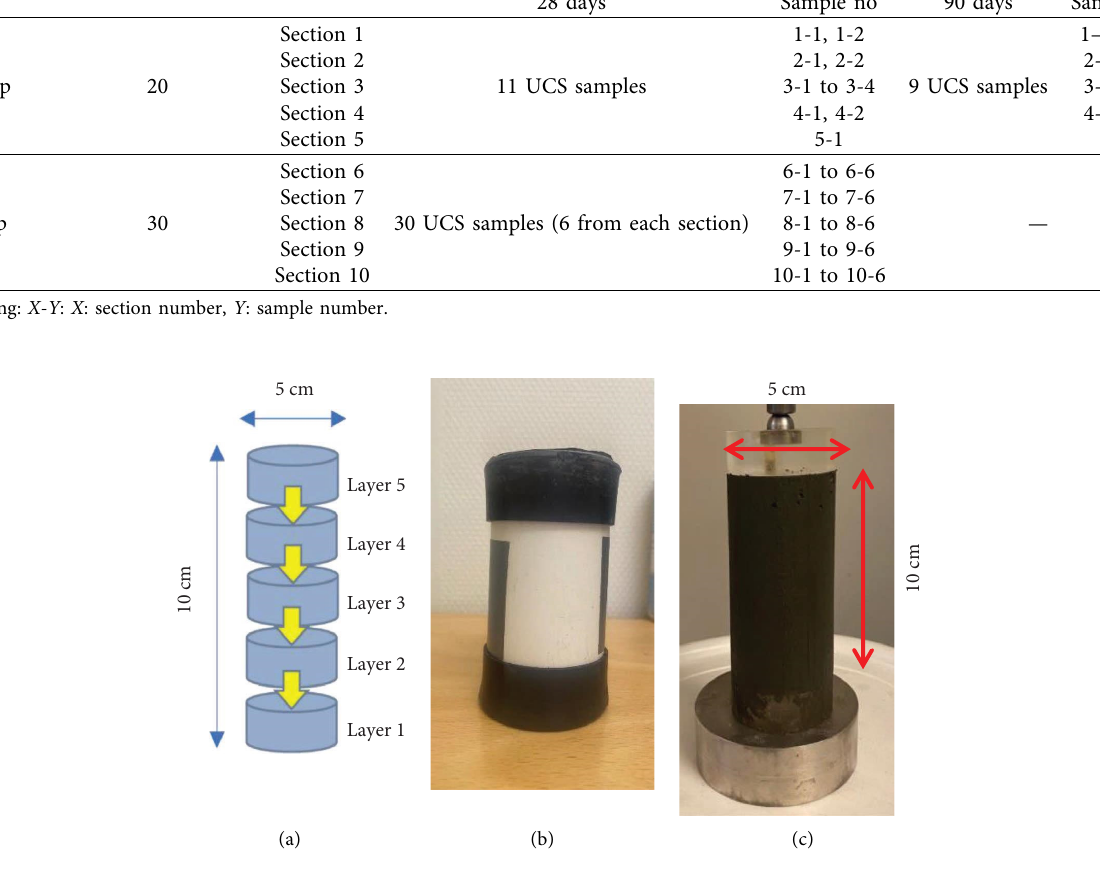
Figure 4: (a) Sample compacted in 5 layers. (b) Prepared sample tube. (c) Prepared sample after curing